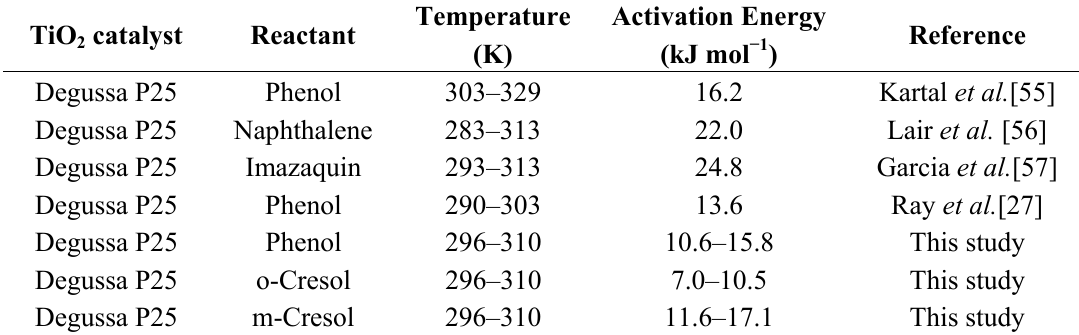
Table 7. Activation energies for selected reactants using Degussa P25